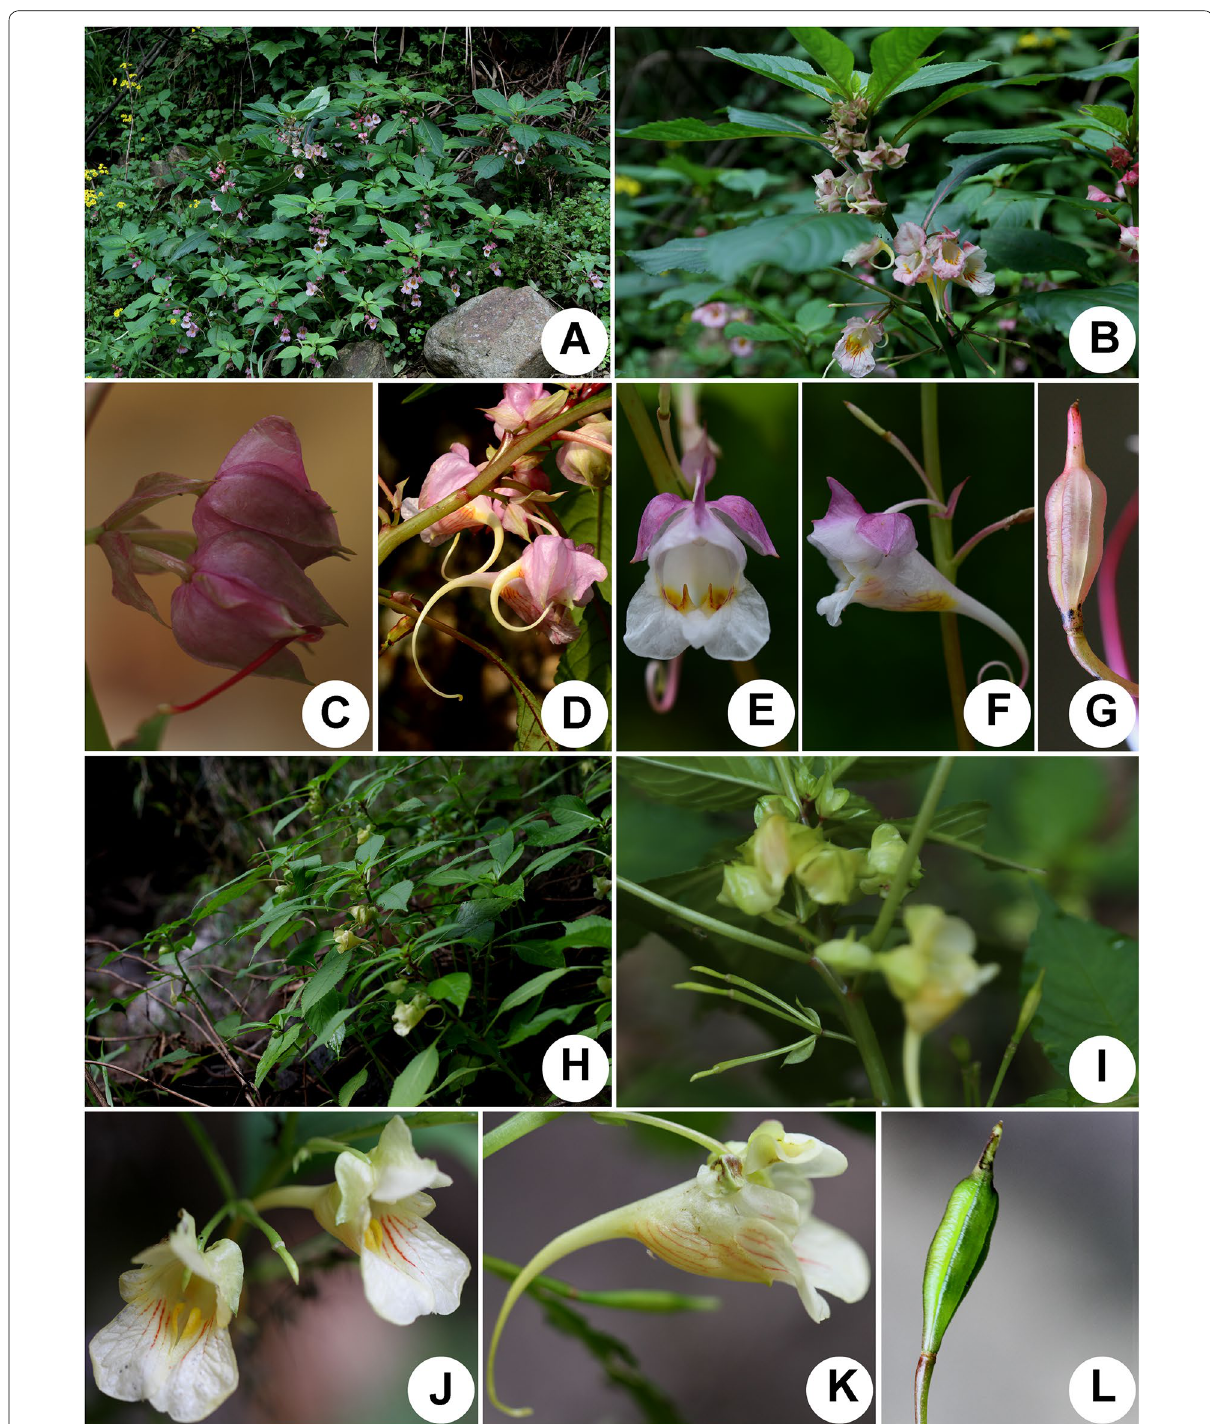
Fig. 6 Impatiens platysepala Y.L.Chen ( a ‒ g ) and I. chloroxantha Y.L.Chen ( h ‒ l ). a habitat; b upper part of plant; c bracts and flowers; d inflorescence; e frontal view of flower; f lateral view of flower; g capsule; h habitat; i inflorescence and bracts; j frontal view of flower; k lateral view of flower; l